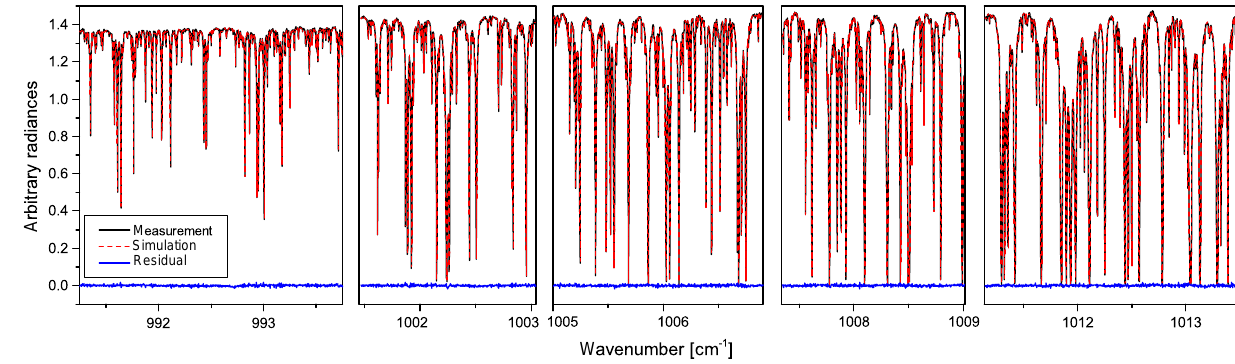
Figure 2. The spectral windows used for the retrievals with the NDACC FTIR instrument at Altzomoni. An example for a typical mea- surement is shown (22 March 2013, 17:51UT; solar elevation: 67.9 ◦ ; O 3 slant column: 283DU). Black line: measurement; red dashed line: simulation; blue line: residual (difference between measurement and simulation).